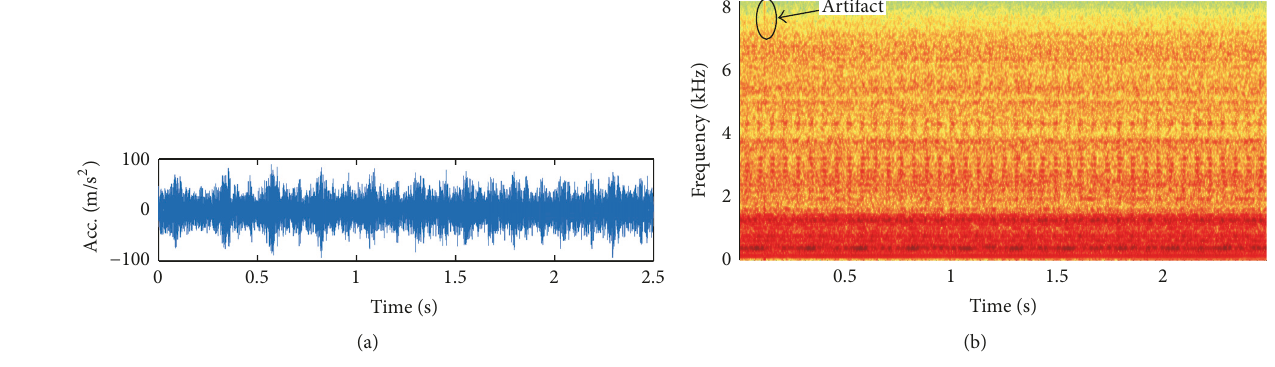
Figure 2: The raw vibration signal (a) and its spectrogram